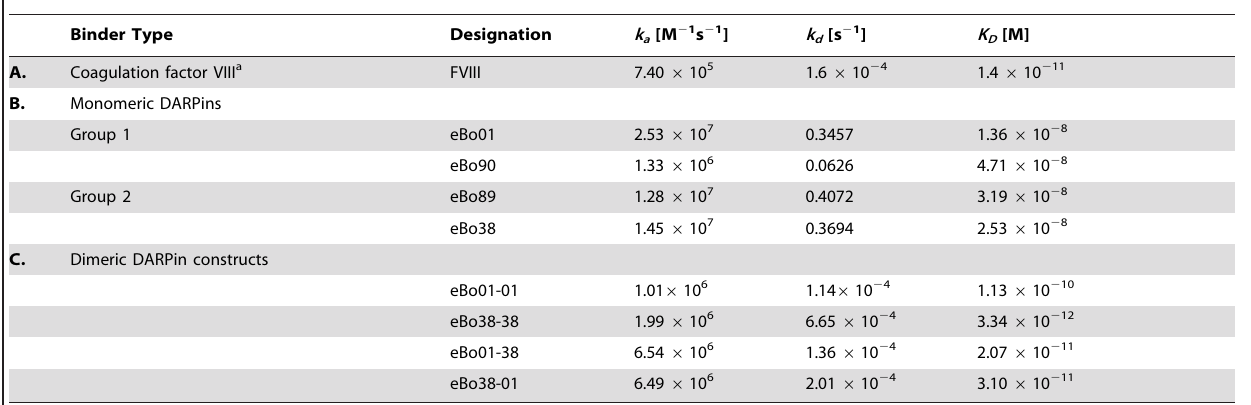
Table 1. Affinities of DARPins and FVIII to Bo2C11.